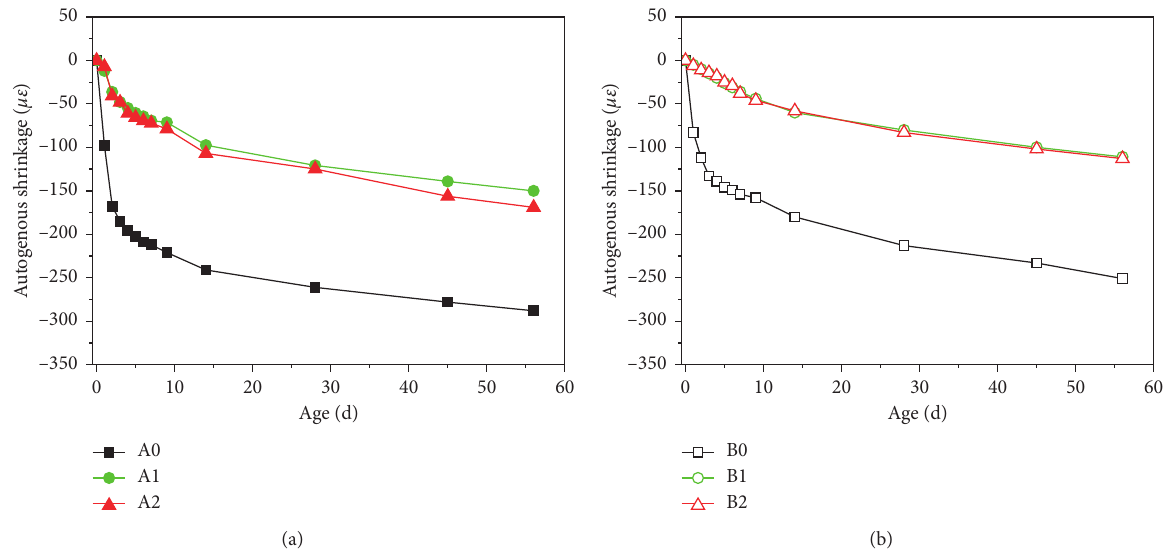
Figure 5: Relationship between autogenous shrinkage and age of concrete. (a) Concrete without FA; (b) concrete with